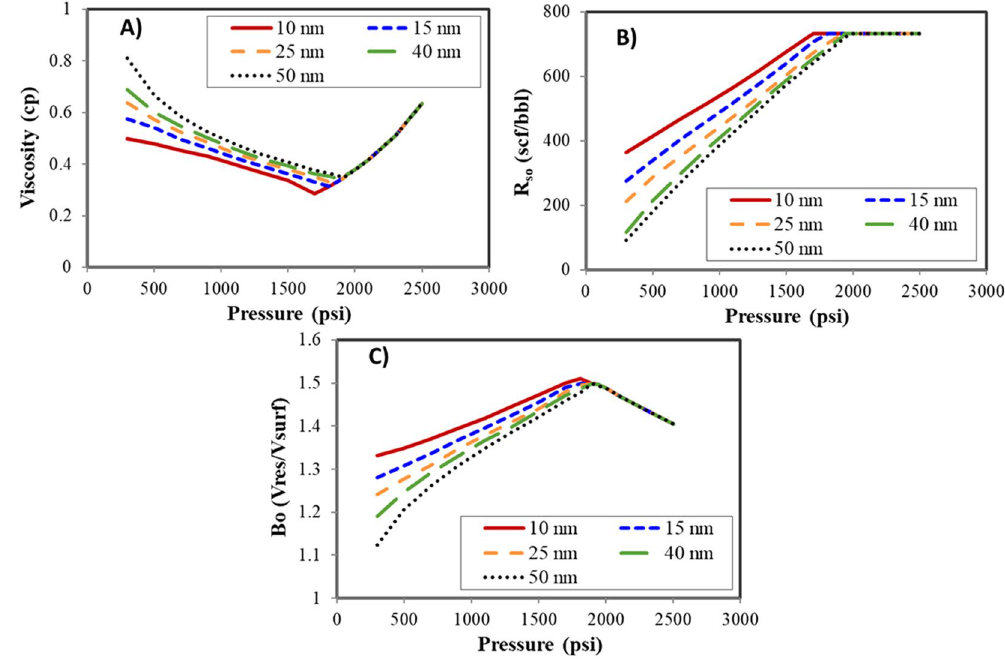
Figure 3. Black-oil properties under different pore sizes. ( A ) Oil viscosity. ( B ) Gas-oil ratio. ( C ) Formation volume factor.